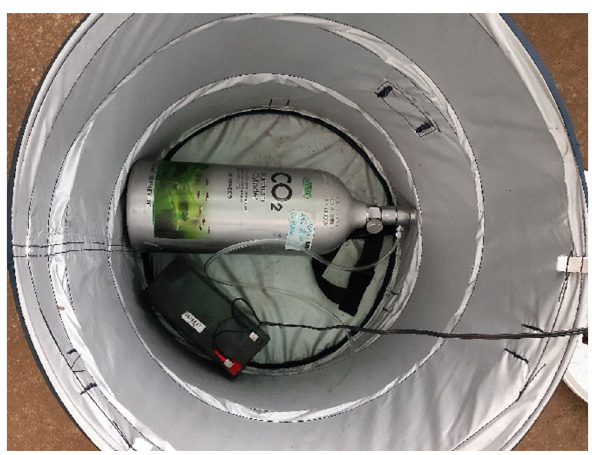
Figure 6. Inside view of a BG-Sentinel trap containing a battery and a CO 2